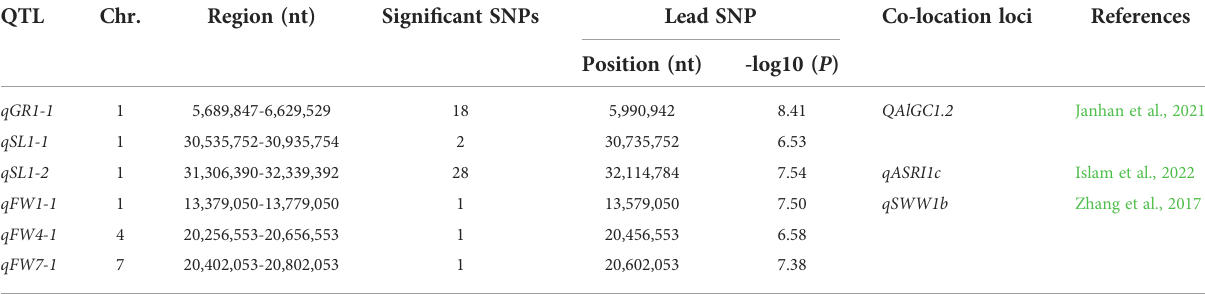
TABLE 2 Six GWAS regions associated with